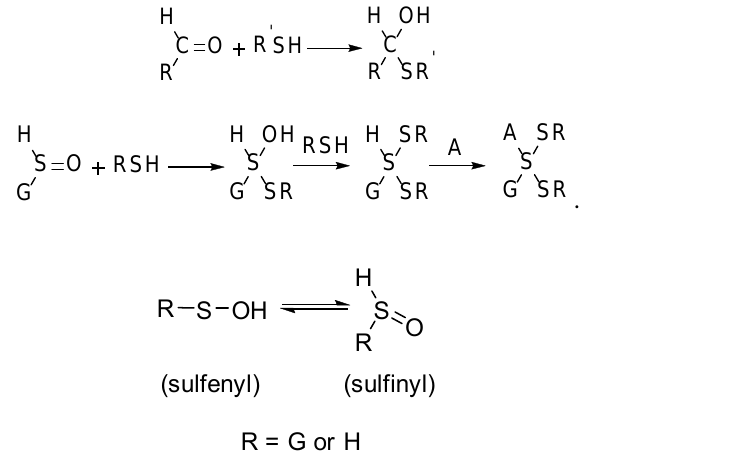
Scheme 3. Sulfenic acid tautomers.